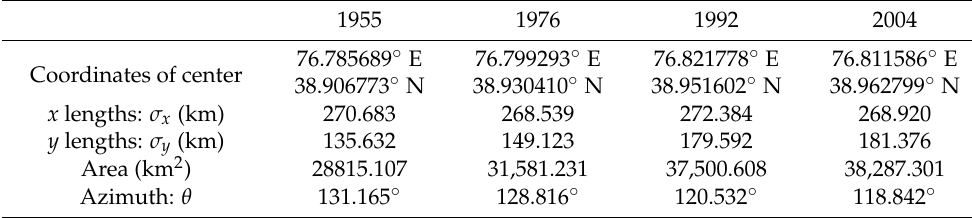
Figure 6. Changes in the SDE of mosque distribution in the Kashgar from 1955 to 2004. Table 4. SDE data for the spatial distribution of mosques in the Kashgar region from 1955 to